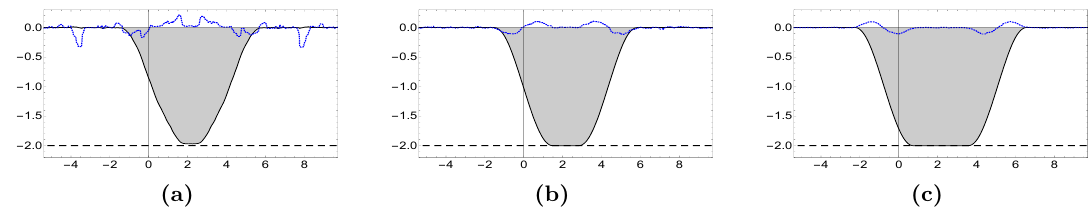
Figure 22. The stable bound state of two kinks for l = 4 : 3156 at (a) t = 19 : 030, (b) t = 73 : 534, (c) t = 237 : 208. The dotted line represents derivative of the (cid:12)eld with respect to time @ t (cid:17) .